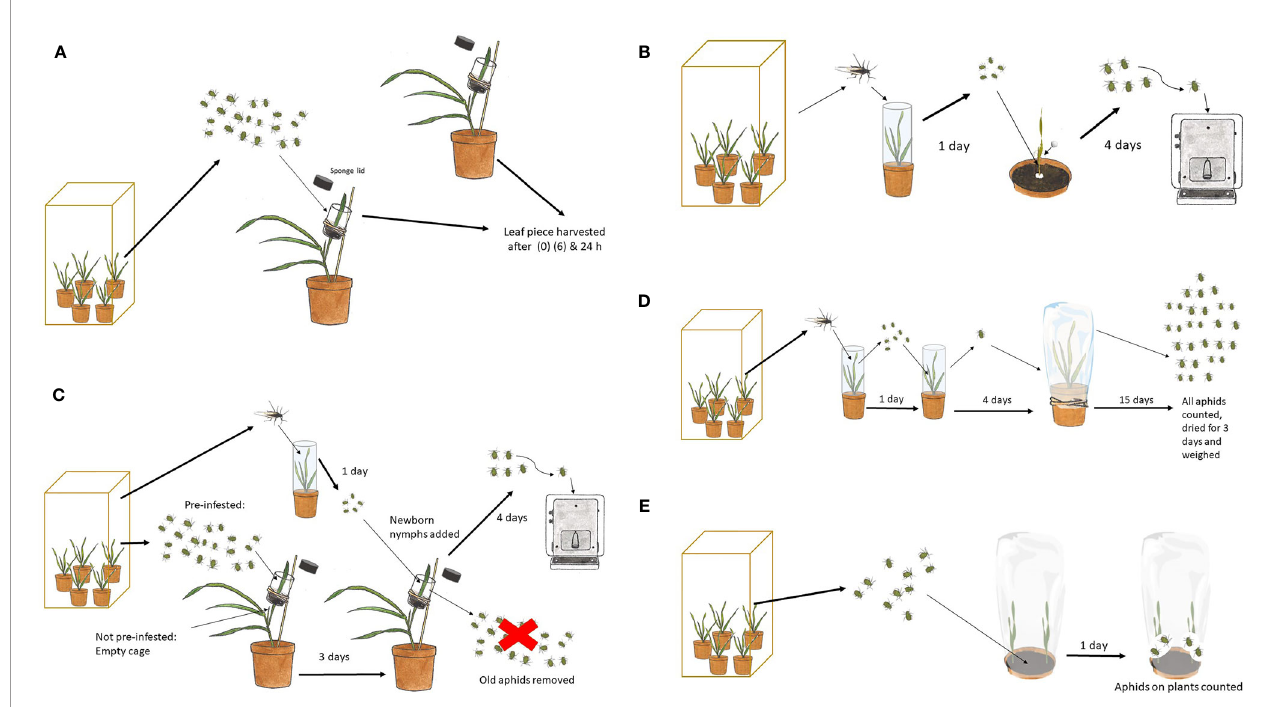
FIGURE 1 | Procedures for tests involving R. padi . (A) Induction with aphids for analysis of plant b -1,3-glucanase regulation. (B) Aphid individual weight after growing on test plants. (C) Aphid individual weight after growing on test plants pre-treated with other aphids compared to not pre-treated. (D) Aphid population size and biomass on test plants. (E) Aphid host choice between a mutant and a control